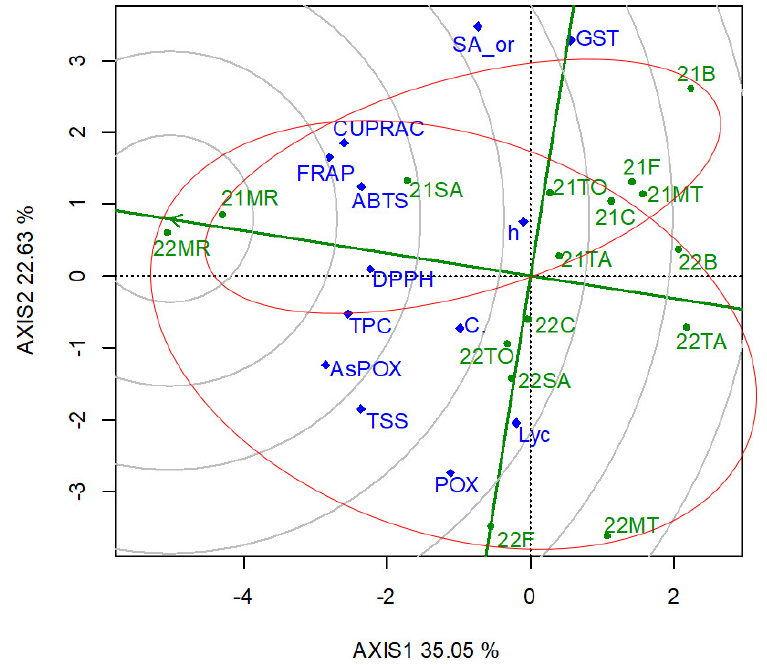
Figure 4. Genotype-focused GGE biplot based on the phytonutrient dataset of the investigated tomato PGRs in 2016. Red oval circles divide datapoints of locations. Legend: green data points, first